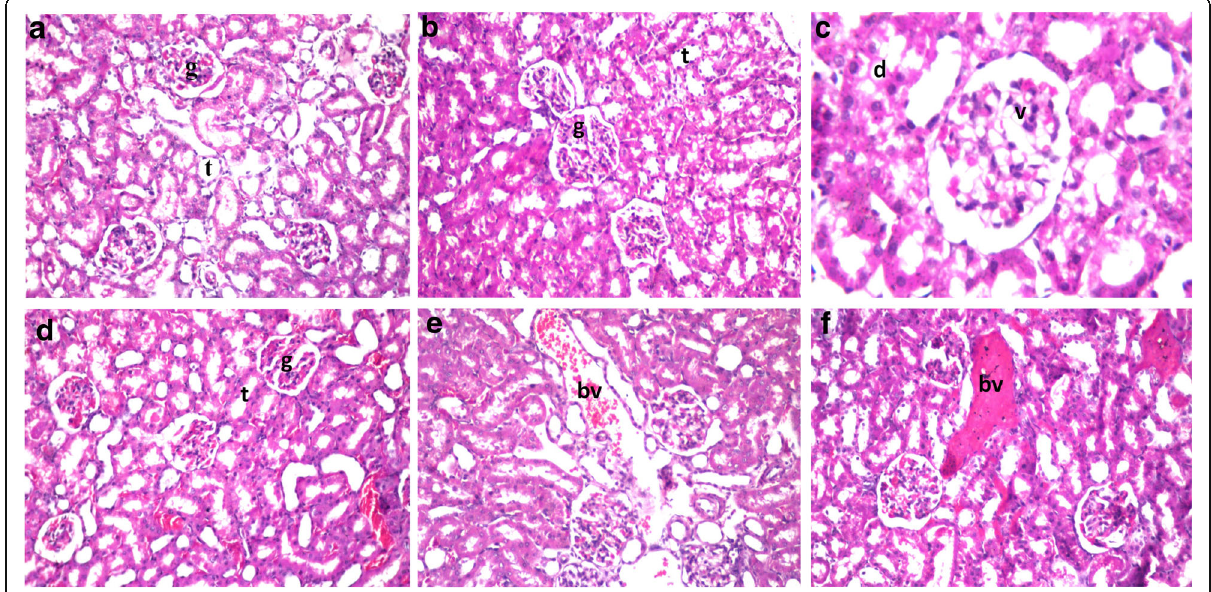
Fig. 3 Kidney tissue showing a control group showing glomeruli (g) and tubules (t) with normal histological structure at the coretx (H&E, × 40), b CS-treated group without deviation from control group (H&E, × 40), c Li-treated group showing vacuolization (v) in endothelial cells lining the tufts of the glomeruli with degeneration (d) in the surrounding tubules (H&E, × 80), d CS pre-treated group without alterations or deviation from control group (H&E, × 40), e CS simultaneous-treated group with congestion in the cortical blood vessels (bv) (H&E, × 40), and f CS post-treated group with congestion in the cortical blood vessels (bv) (H&E, ×